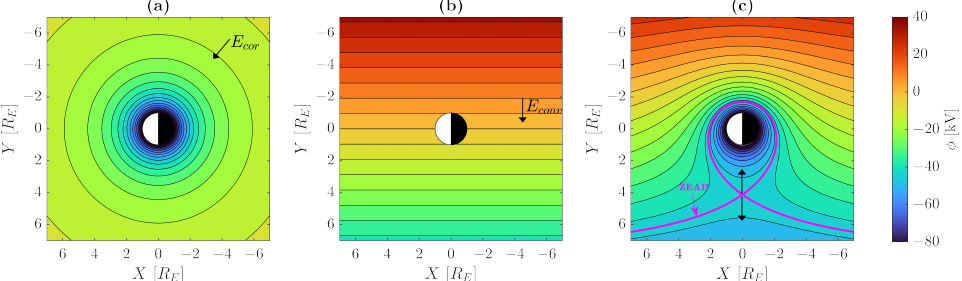
Figure 1. Corotation ( a ), convection ( b ) and resulting ( c ) electric potential in the magnetic equatorial plane. The convection field was determined by assuming a dawn–dusk electric field of 0.82 mV/m. The black solid curves are equipotential lines, corresponding to plasma streamlines. The black arrows depict the electric field direction. The magenta line in panel ( c ) is the separatrix between close and open drift